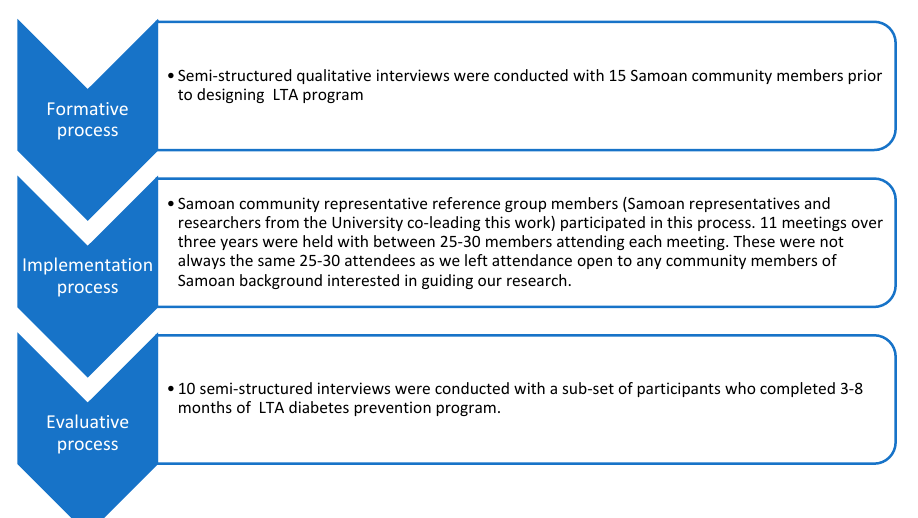
Figure 3. Data collection